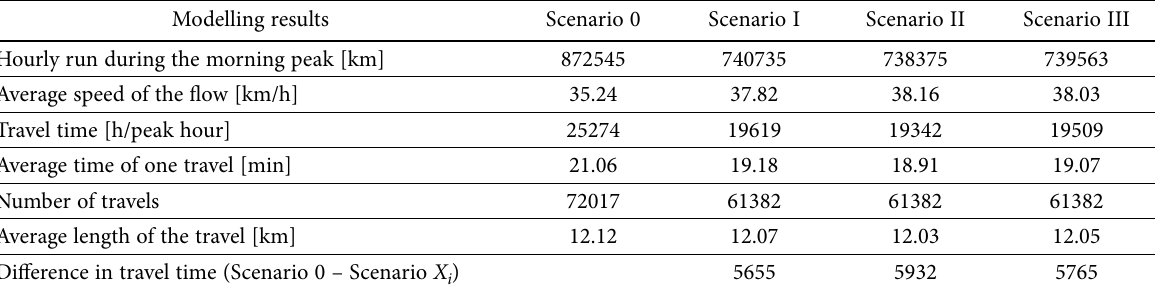
Table 2. Qualitative modelling results Modelling